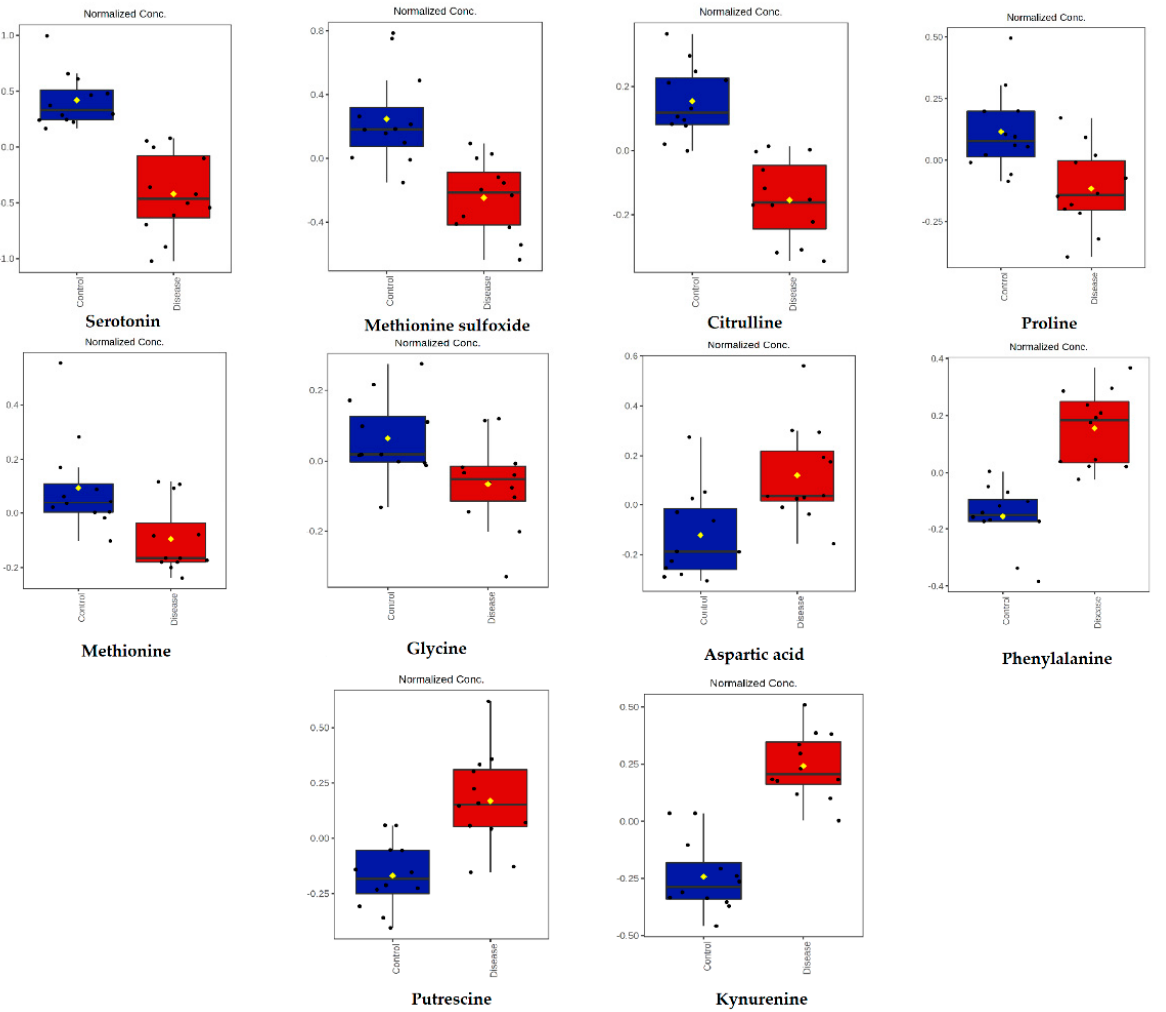
Figure 3. Concentrations of metabolites significantly altered in dogs infected with B. canis determined by the targeted LC-MS metabolomics approach. Data are presented as box and whiskers plot (mean ± SD). All metabolites shown demonstrated a statistically significant difference between groups by t -test ( p < 0.05). Blue-control samples, red-disease samples.